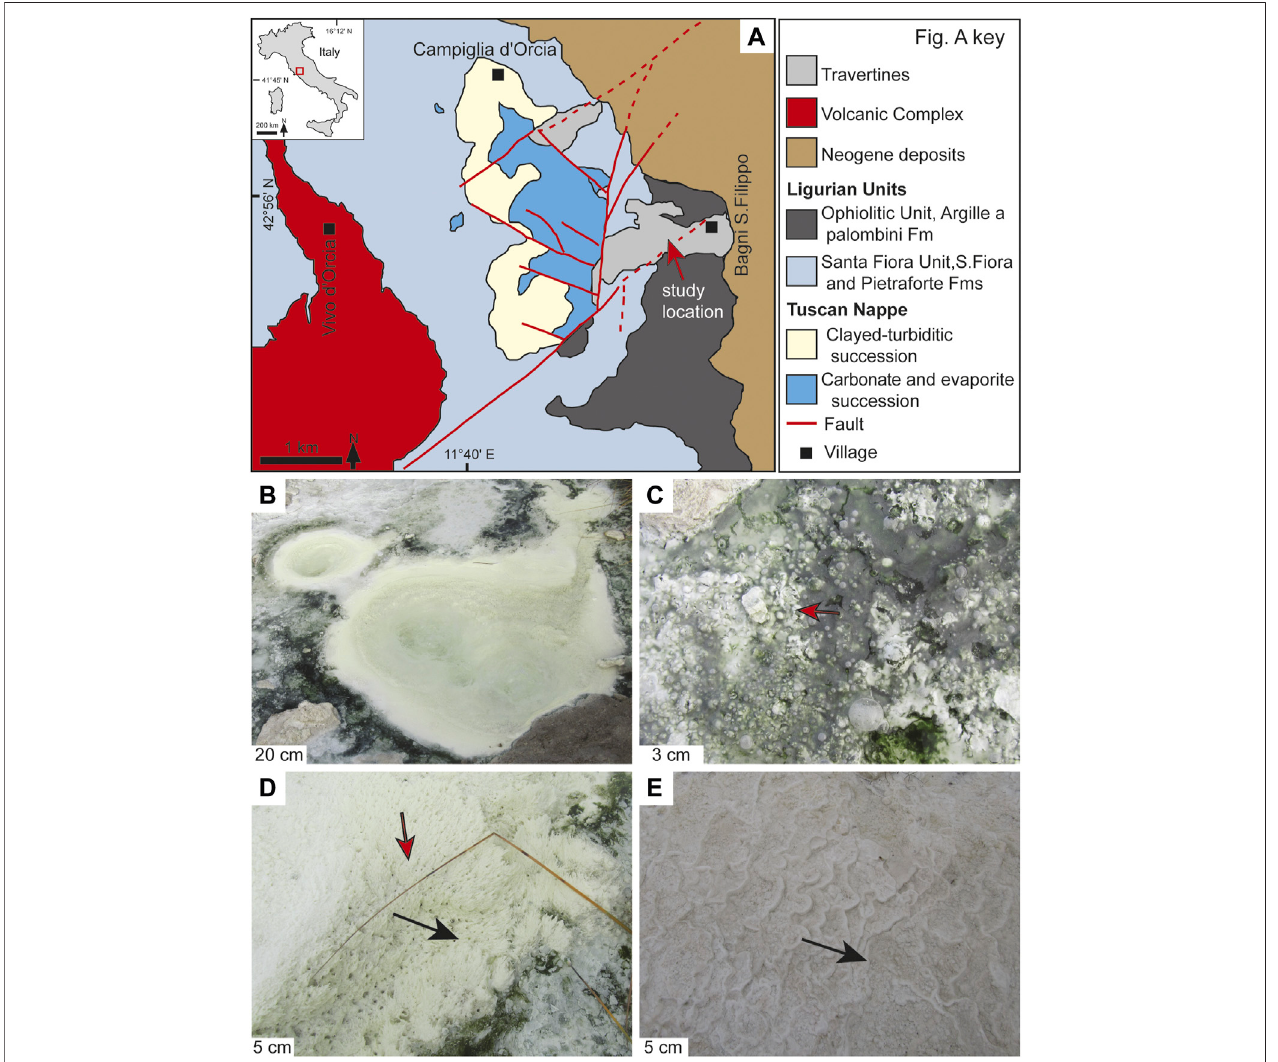
FIGURE 3 | Geological and sedimentary background of hydrothermal travertines at Bagni San Filippo, Tuscany, Central Italy (A) Geological map of the Bagni San Filippo area (modi fi ed after Brogi and Fabbrini, 2009), the study location is indicated by the red arrow (B) Circular vent ori fi ces in the travertine mound (C) The pool surrounding the vent ori fi ces with 0.1 – 1 mm thick rafts and coated gas bubble (red arrow) on the stagnant water (D) Encrusted fi lamentous streamers (red arrow) near the vent; black arrow indicates thermal water fl ow direction (E) Micro-terraced (mm to cm-scale) travertines along a channel nearly 20 m away from the vent; black arrow indicates slope dip and thermal water fl ow